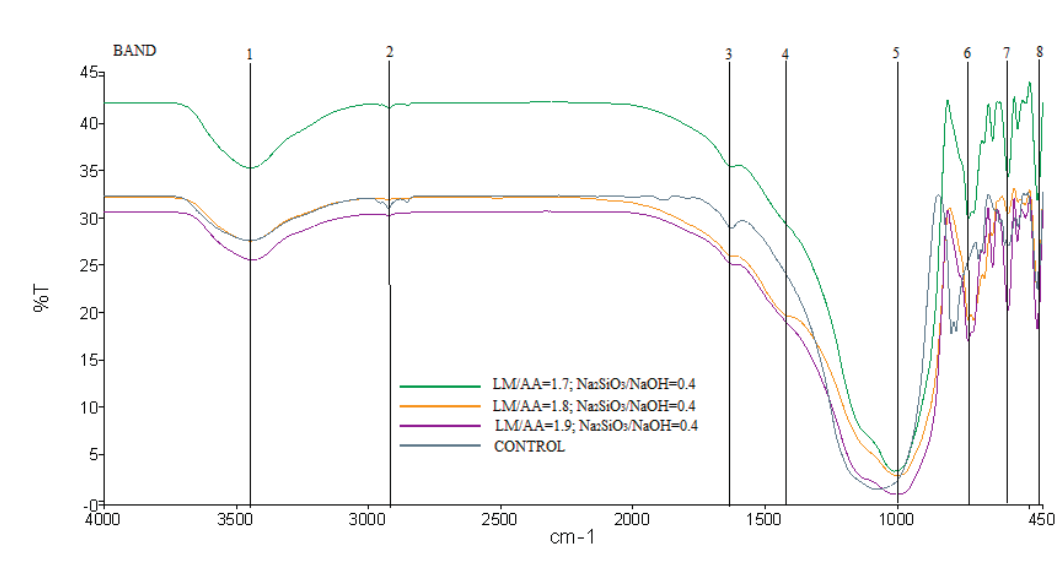
Figure 9. FTIR spectra of ALGA produced at LM/AA ratio of 1.7, 1.8, and 1.9 with Na 2 SiO 3 /NaOH ratio of 0.4 and control sample.